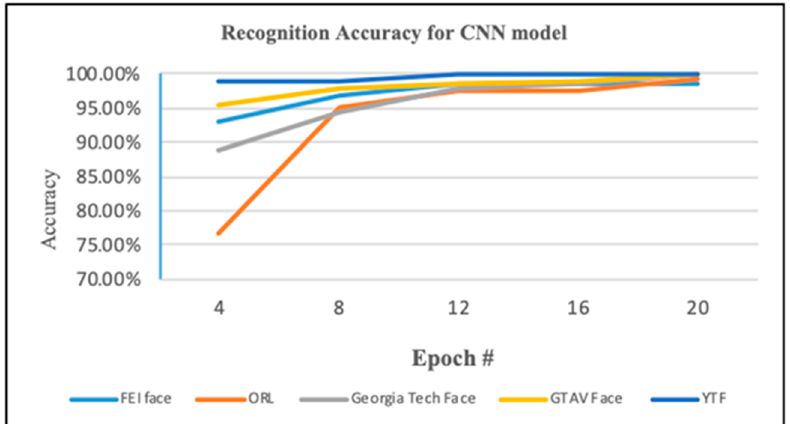
Figure 9. Transfer learning from AlexNet convolutional neural networks.